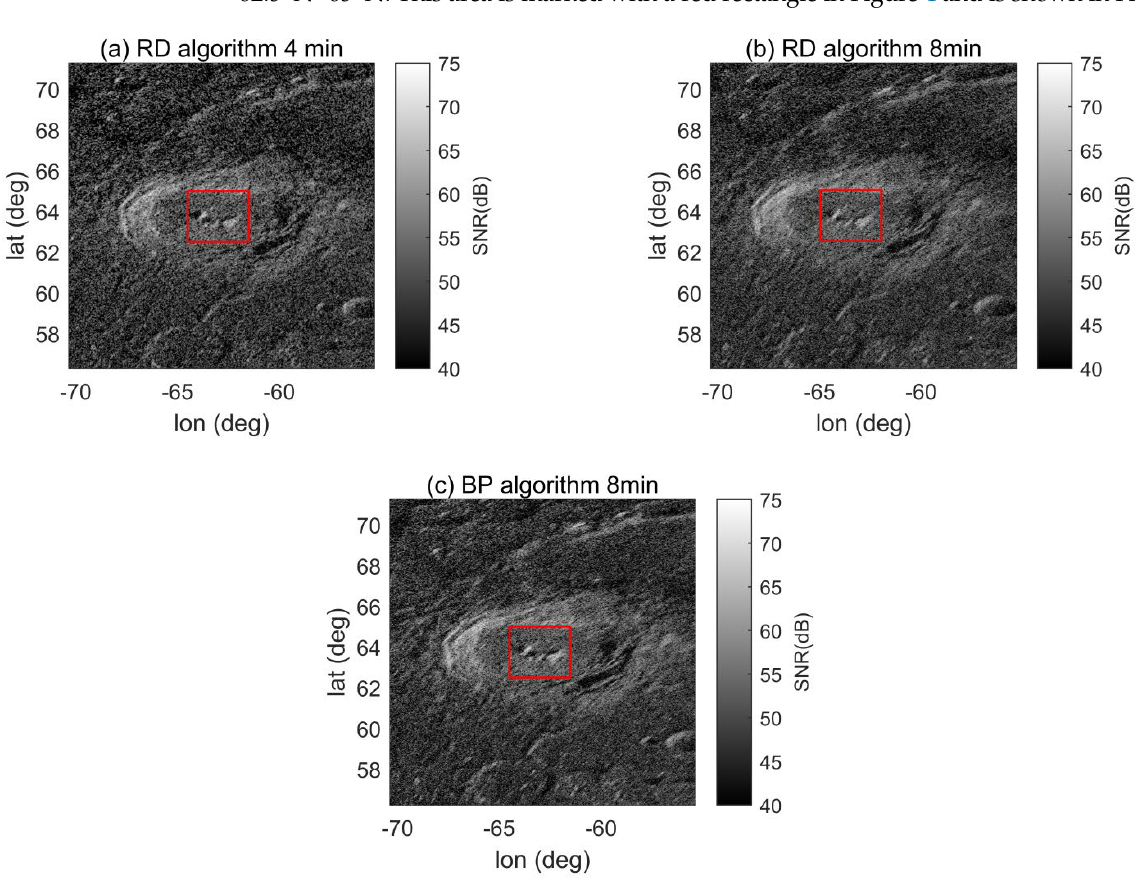
Figure 4. Imaging results of the Pythagoras crater region on the northern hemisphere of the front side of the moon. The imaging longitude range is 70.37° W~55.37° W. The latitude range is 56.24° N~71.24° N. The grid point step size is 0.02°. ( a ) Image obtained by the range-Doppler algorithm with a coherent integration time of 4 min. ( b ) Image obtained by the range-Doppler algorithm with a coherent integration time of 8 min. ( c ) Image obtained by the back projection algorithm with a coherent integration time of 8 min. The red rectangle on each image represents the magnified area shown in Figure 5.